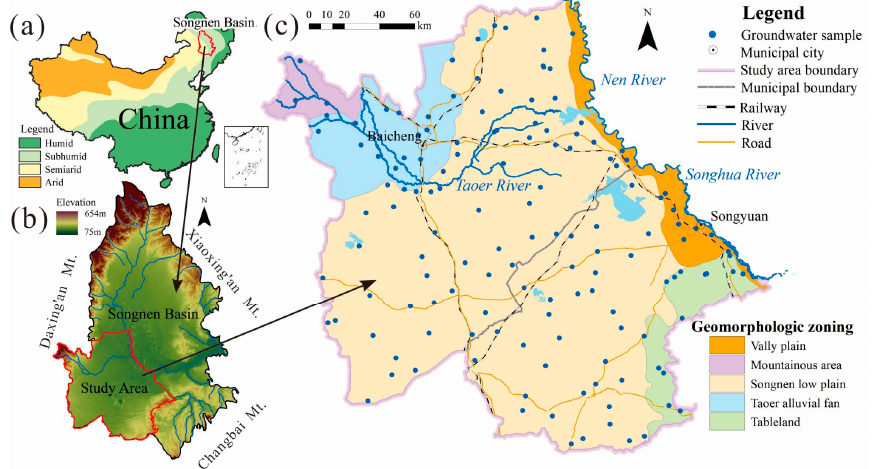
Figure 1. Location of the study area. ( a ) Songnen Plain in China and China climate zonation, ( b ) the terrain of the Songnen Plain and the study area in the Songnen Plain, ( c ) landform division and sampling point distribution map of the study